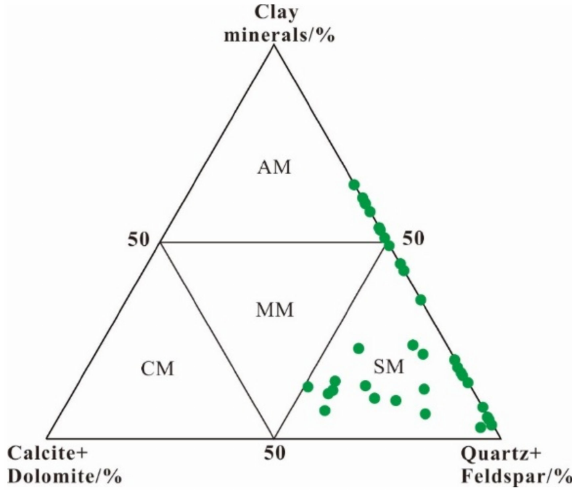
Figure 2. Lithofacies classification of studied Niutitang shale samples.